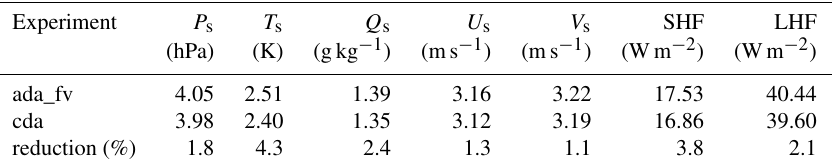
Figure 13. Time series of RMSEs of (a) surface pressure P s , (b) surface temperature T s , (c) surface specific humidity Q s , (d) surface zonal wind U s , and (e) surface meridional wind V s from ada_fv and cda. Table 5. Globally averaged RMSEs of surface pressure P s , surface temperature T s , surface specific humidity Q s , surface zonal wind U s , surface meridional wind V s , sensible heat flux SHF, and latent heat flux LHF from ada_fv and cda. The RMSEs are calculated with the data of the first month